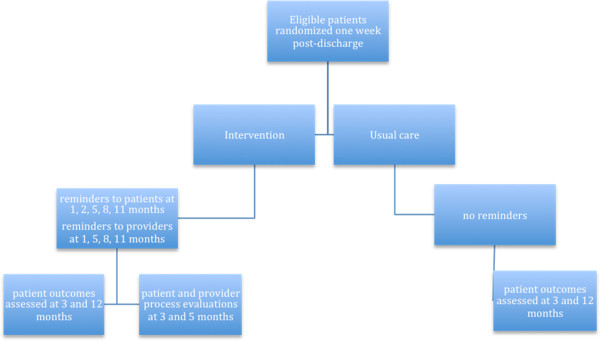
Study Flow Diagram.